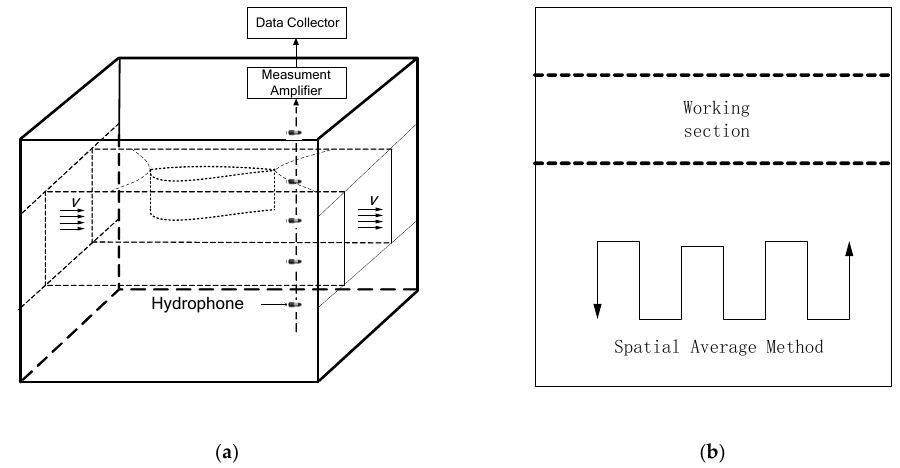
Figure 22. The diagram of the experimental measurement. ( a ) The composition of the vertical hydrophone array; ( b ) The spatial average